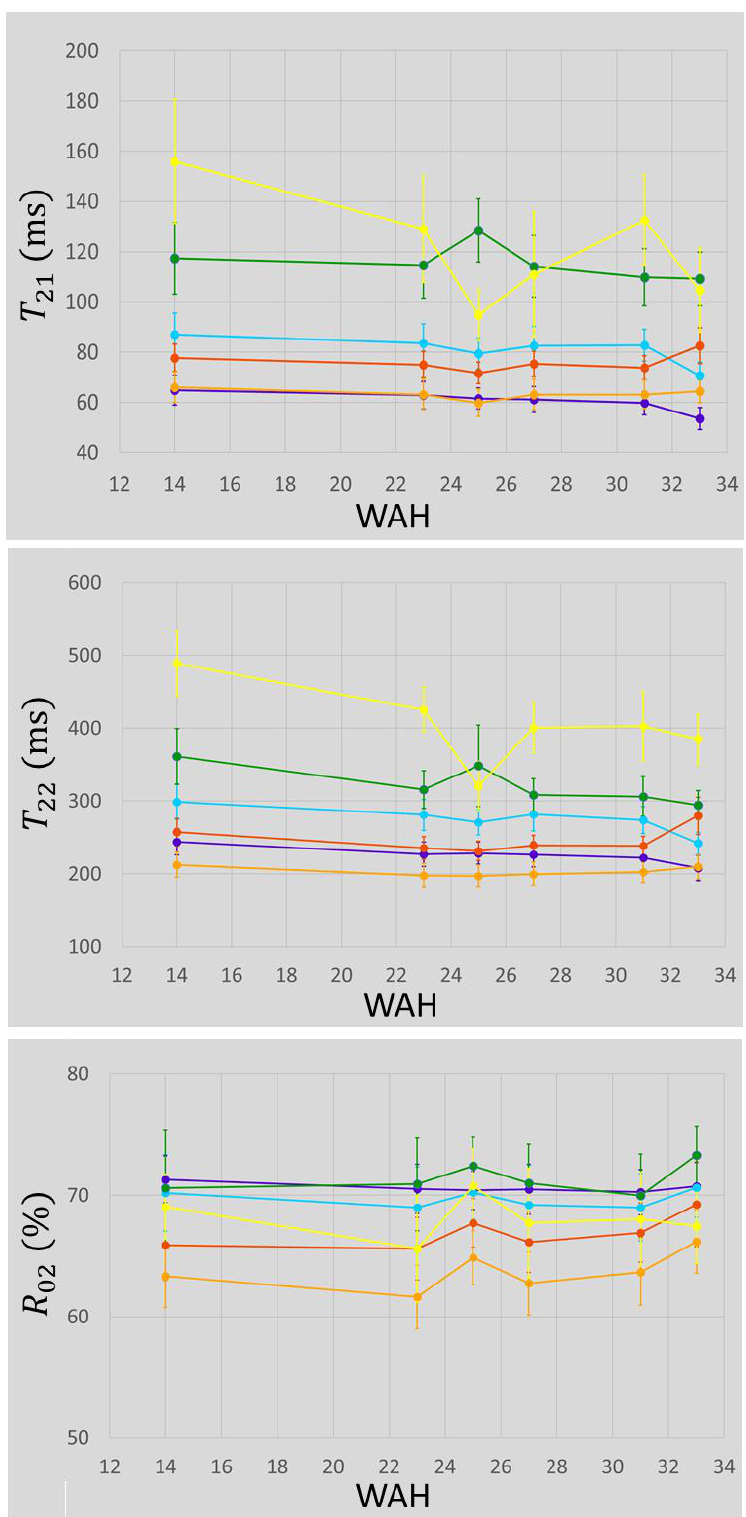
Figure 7. Evolution of the mean values of T 21 , T 22 and R 02 over time. Error bars correspond to standard deviations. Colors were attributed regarding both T 22 and spatial information as detailed in the text. On average, purple could be attributed to cortex, green to the pith and yellow to the defects, the three other colors, light and dark orange and cyan, to the flesh.